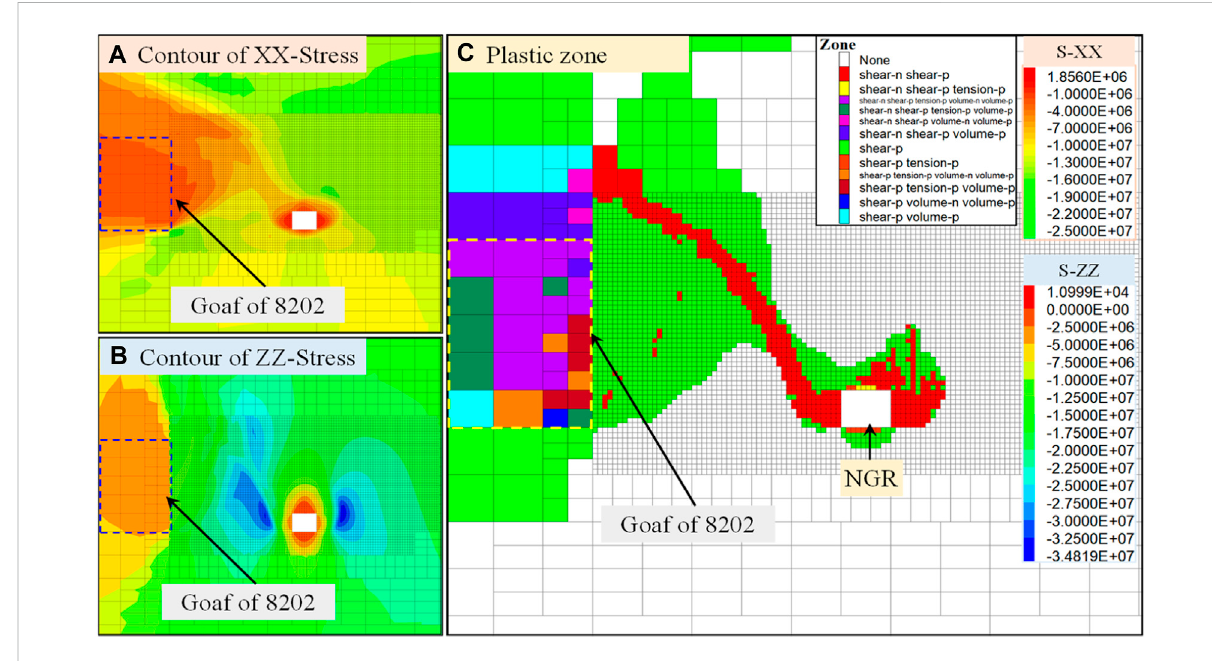
FIGURE 10 Plastic zone and regional stress fi eld distribution of the surrounding rock, only in the presence of the nearby goaf road.